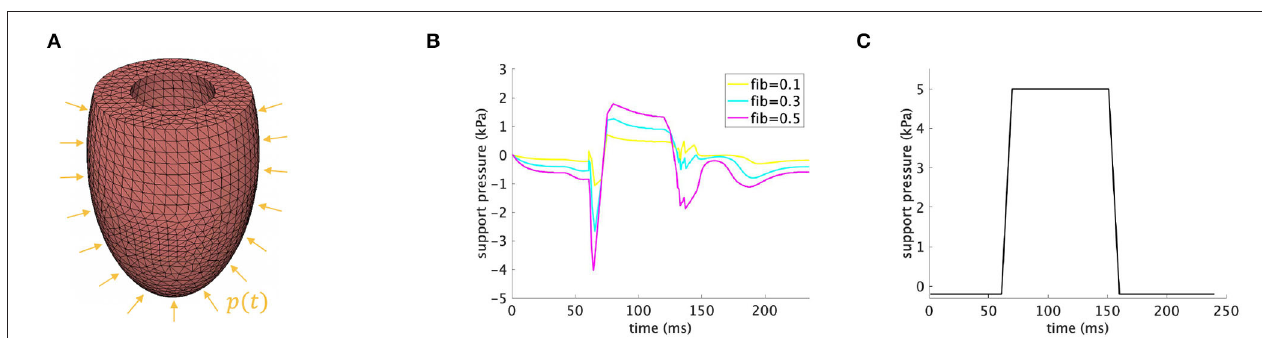
FIGURE 2 | (A) Discretized model of the rat LV with applied support pressure p ( t ) on the epicardial surface. (B) Time-dependent support pressure according to Equation (8) for fib ∈ { 0.1,0.3,0.5 } . (C) Time-dependent support pressure according to Equation (9).